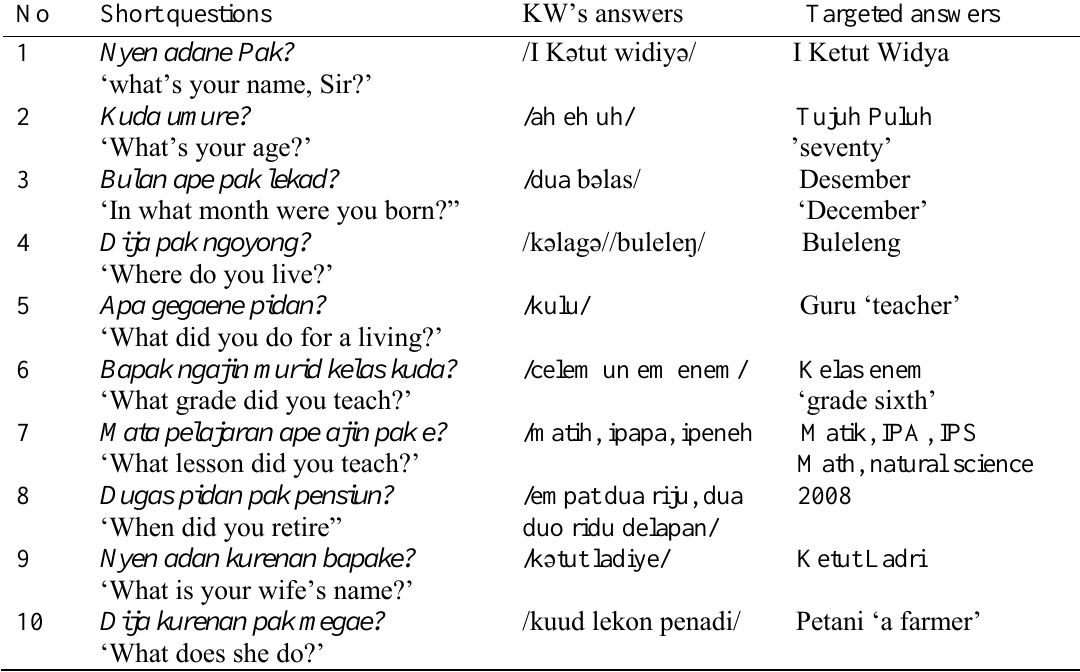
Table 3 Forms and Types of Phonological Errors in Answering Short